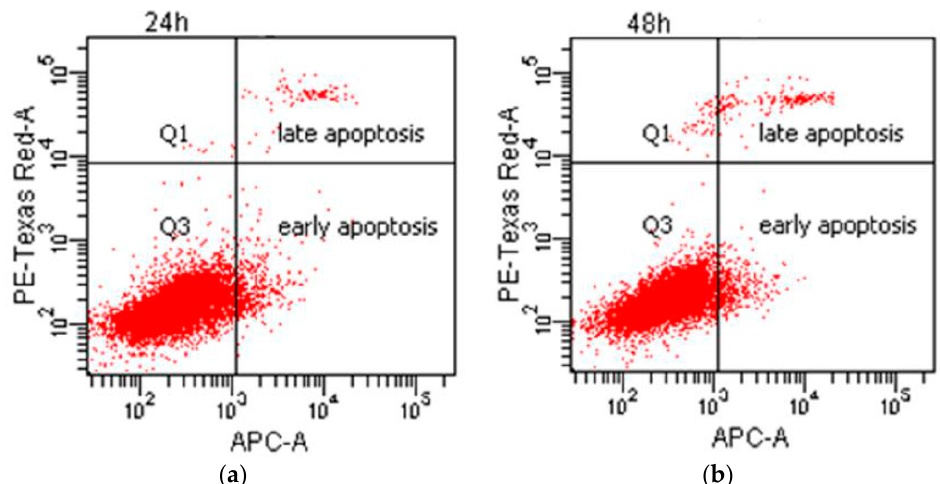
Figure 8. Type of cell death of L929 cells exposed to Cu 25 Ti 75 extract. Dot plot charts represent the